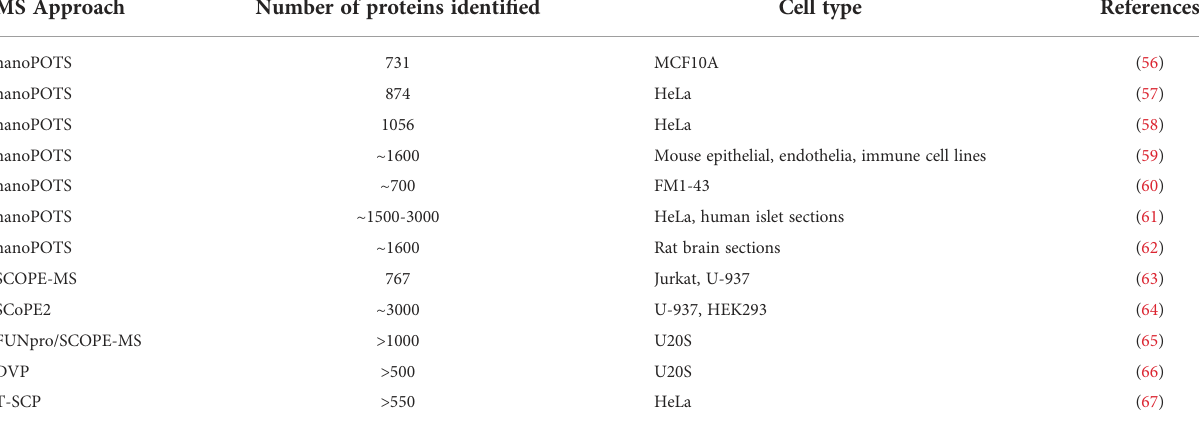
(Table 1; Figure 1) The implementation of micro fl uidic chip systems, facilitating reactions to occur in a small volume, has greatly accelerated this approach. ProteoCHIP and nanodroplet processing in one pot for trace samples (nanoPOTS) are two such designs (61, 68). For example, nanoPOTS uses a chip-based TABLE 1 Recent Single-cell Proteomic